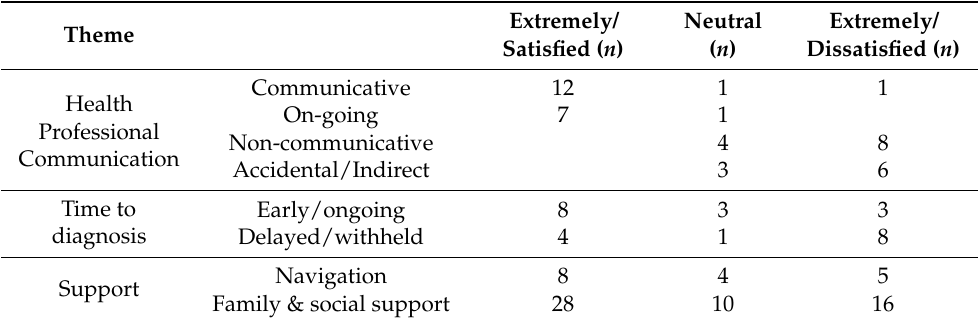
Figure 2. Main and sub-themes in open-ended responses to family survey. Dotted lines indicate links between themes: ( 1 ) Lack of information and support were linked themes, families without information noted feeling unsupported. ( 2 ) Responses describing ‘communicative’ health professionals frequently also described receiving information, linking the two themes. ( 3 ) Families describing an ‘on-going’ communication style from health professionals regarding diagnosis also described their diagnostic experience positively, though it remained lengthy in many cases. ( 4 ) Families describing extreme frustrations with delayed diagnosis also described feeling not listened to and not supported, linking the two themes. ( 5 ) Families who experienced a delayed diagnosis noted their lack of diagnostic information was harmful to accessing beneficial targeted therapy. Table 3. Number of free text responses containing content relating to key themes, stratified by family satisfaction of diagnosis